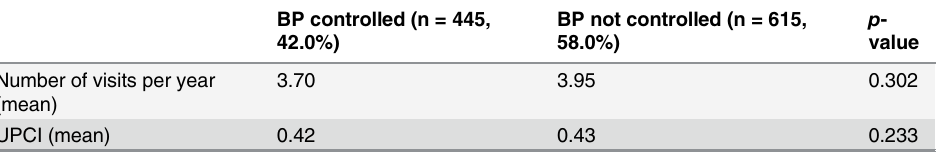
Table 3. Number of visits and personal continuity among patients with controlled and uncontrolled blood pressure.